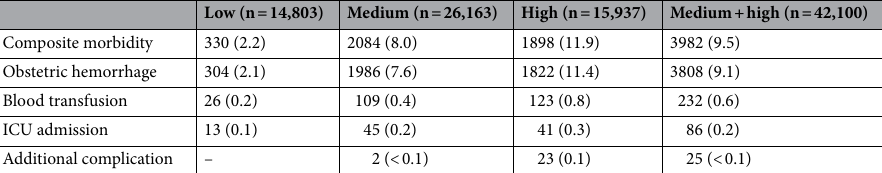
Table 3. Frequency of composite morbidity and individual components to composite across risk groups.